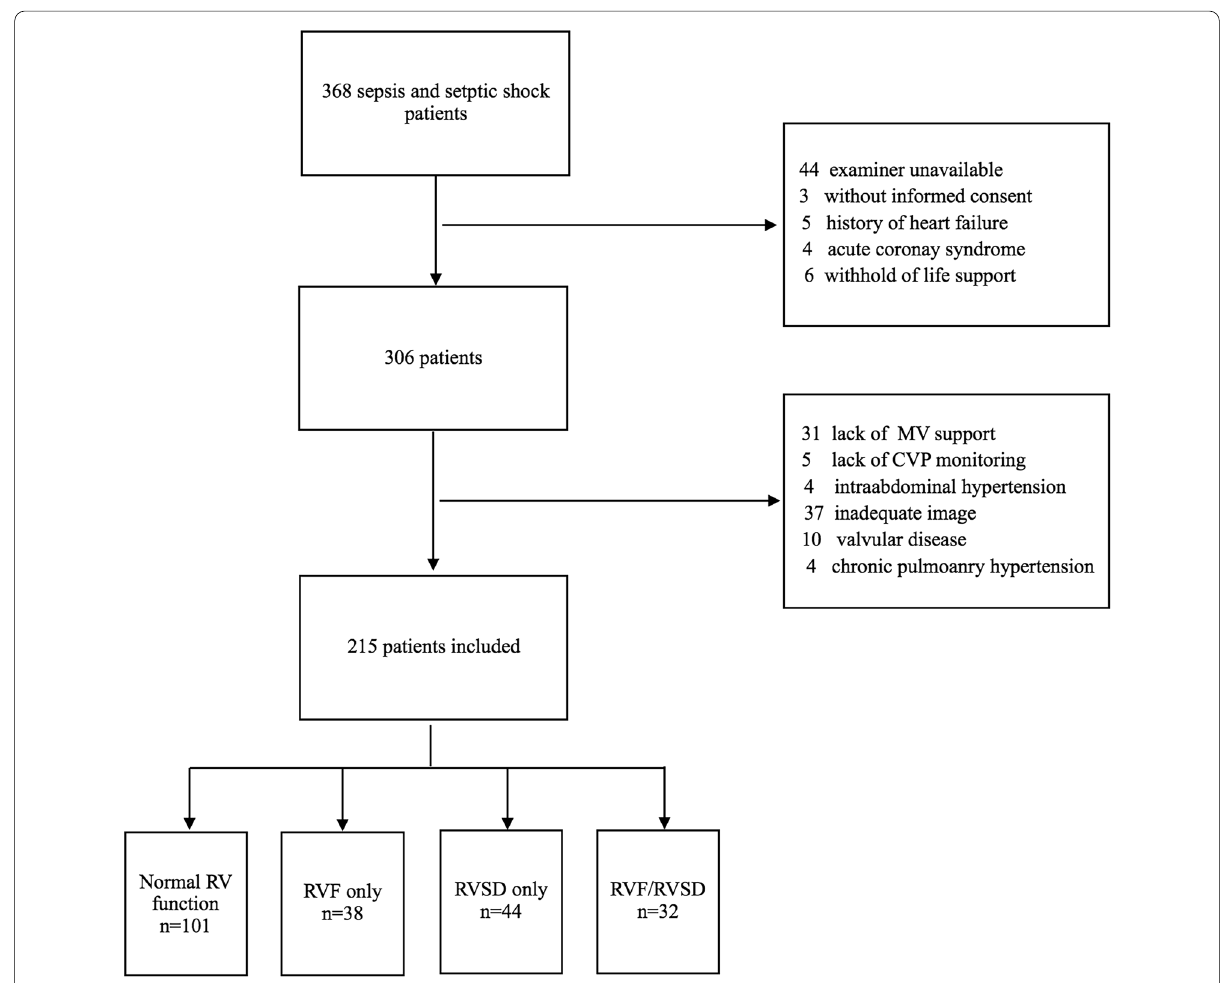
Fig. 1 Flowchart of the study. MV mechanical ventilation, CVP central venous pressure, RV right ventricle, RVF only patients with RV failure but without RV systolic dysfunction, RVSD only patients with RVSD but without RV failure; RVF/RVSD patients with combined